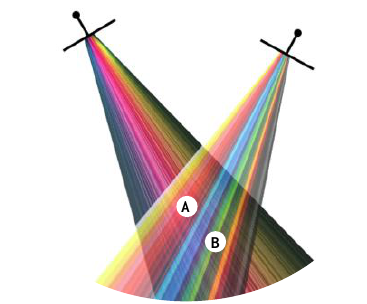
Figure 2. Illustration of the reprojection-error field. Region A is of low reprojection-error as its projection color in both images is red. On the other hand, the reprojection-error of region B is high due to the collision between red and green colors of its image projection.